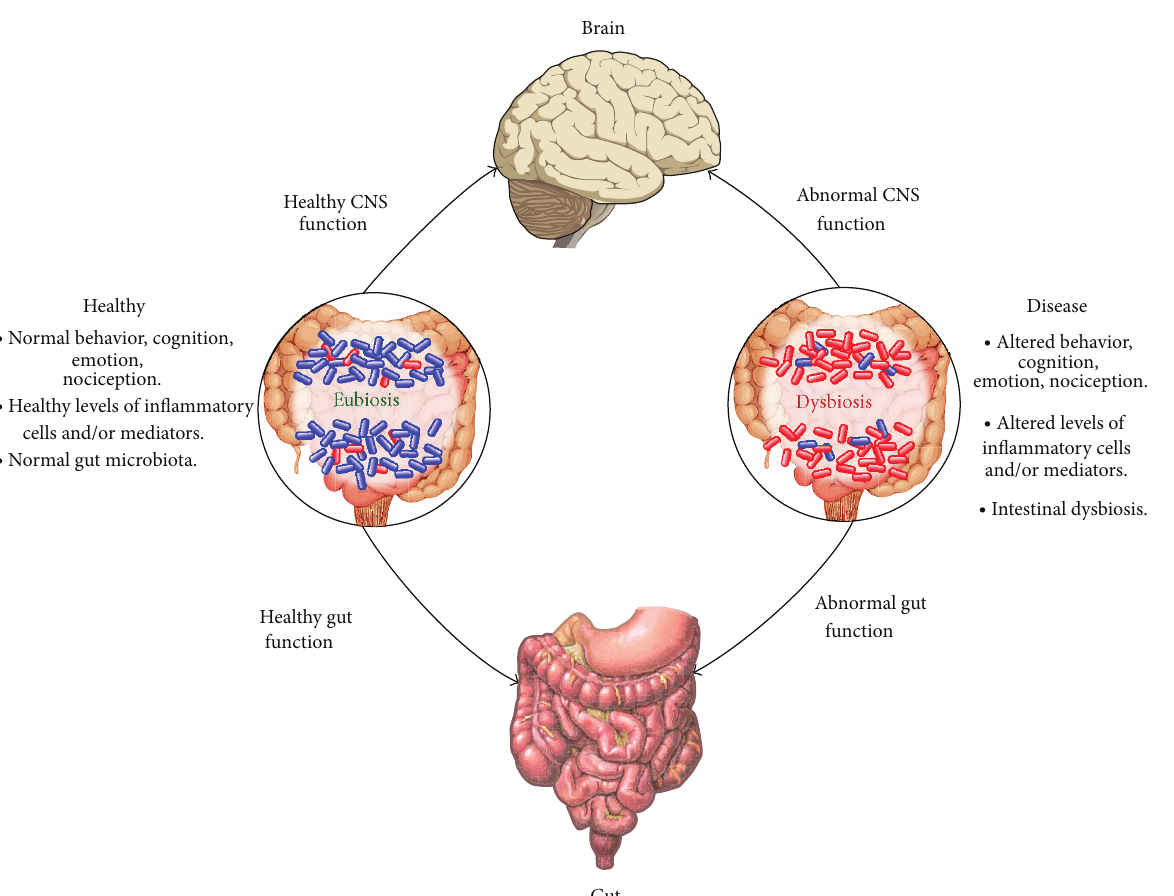
Figure 6: Impact of the gut microbiota on the gut-brain axis in health and disease. It is now generally accepted that a stable gut microbiota is essential for normal gut physiology and contributes to appropriate signaling along the gut-brain axis and, thereby, to the healthy status of the individual (a). On the other hand (b), intestinal dysbiosis can adversely influence gut physiology, leading to inappropriate gut-brain axis signaling and associated consequences for CNS functions and resulting in disease states. Conversely, stress at the level of the CNS can affect gut function and lead to perturbations of the microbiota. (Adapted from: Cryan J, Dinan T. Mind-altering microorganisms: the impact of the gut microbiota on brain and behavior. Nat Rev Neurosci., 13(10):701-12,